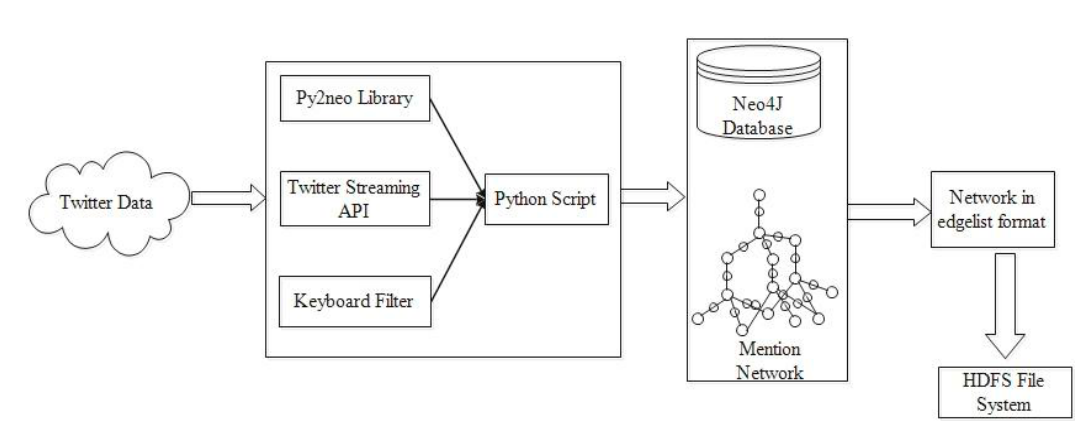
Figure 1. MapReduce programming architecture consisting of Input, Sort & Shuffle and Output stages.